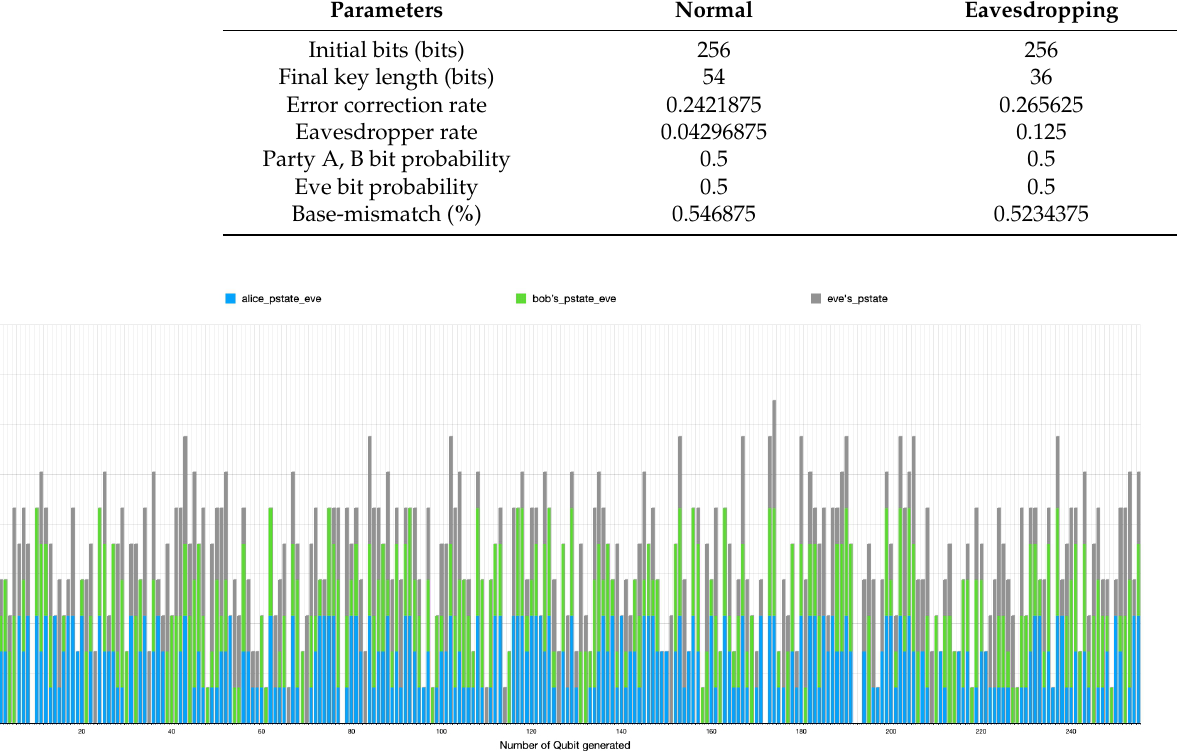
Figure 15. A 2D stacked bar chart with the sender’s, receiver’s, and Eve’s polarization states in the second simulation instance (with the presence of Eve), indicating the chosen and measured qubit randomness.